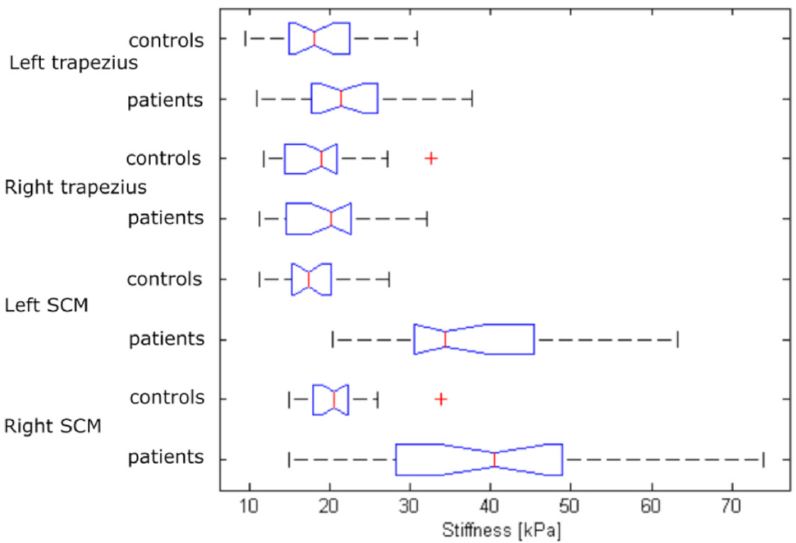
Fig. 4. A less detailed overview of the distribution of muscle stiffness values. In the case of the sternocleidomastoid muscle (SCM), the number is an average of the four medians shown in Fig.